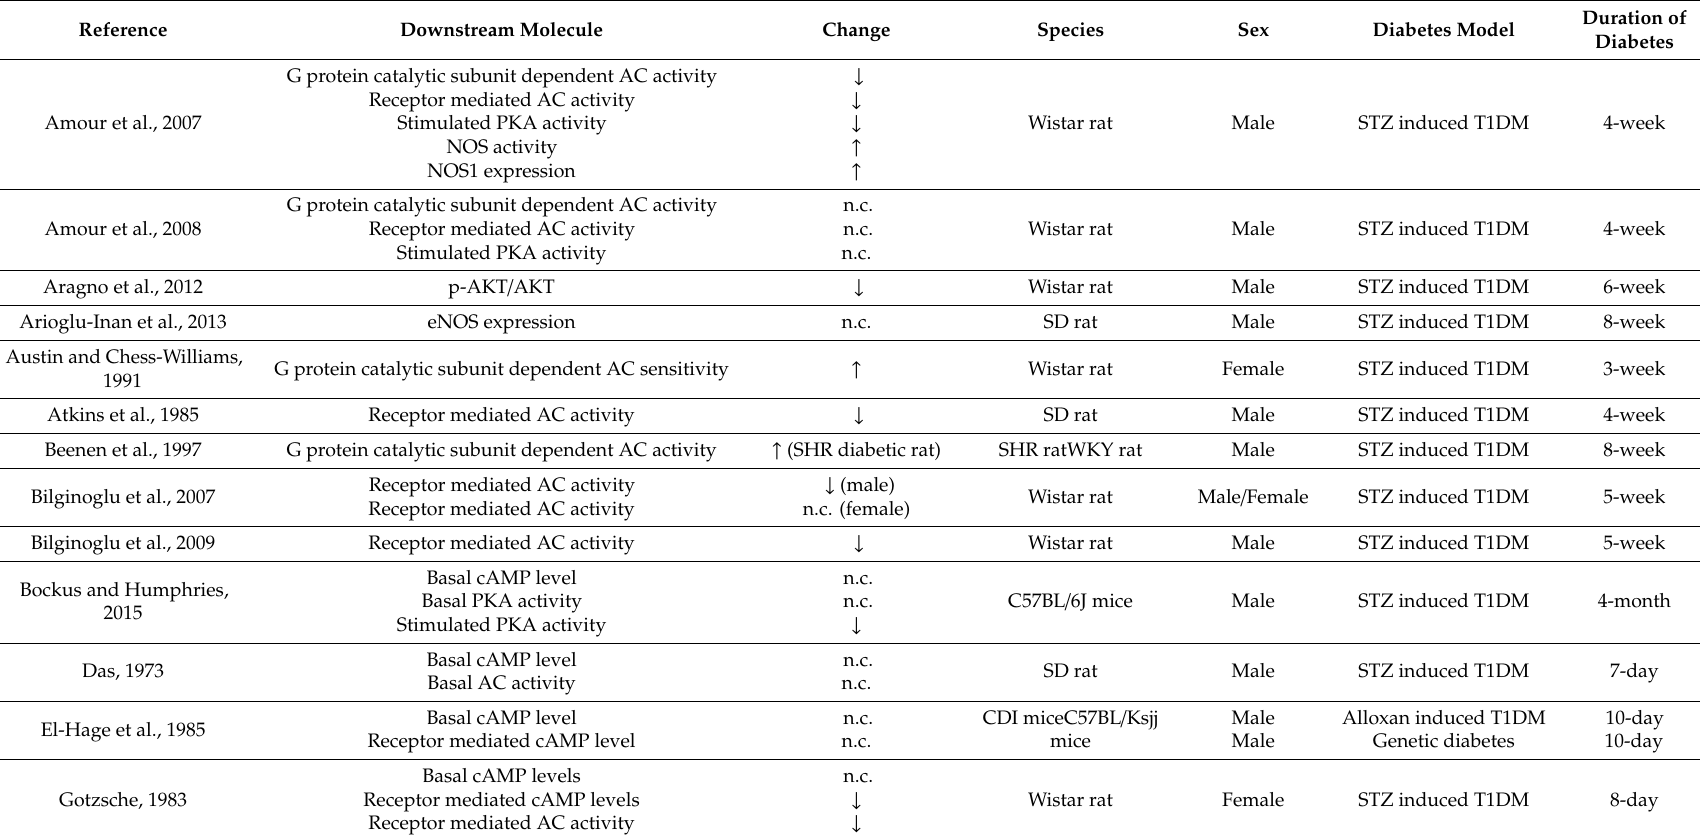
Table 2. The change in cardiac β -AR signaling pathway in T1DM and